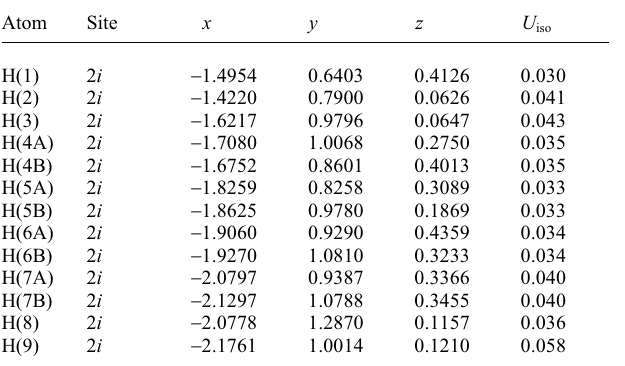
Table 2. Atomic coordinates and displacement parameters (in Å 2 ) . Table 2. Continued